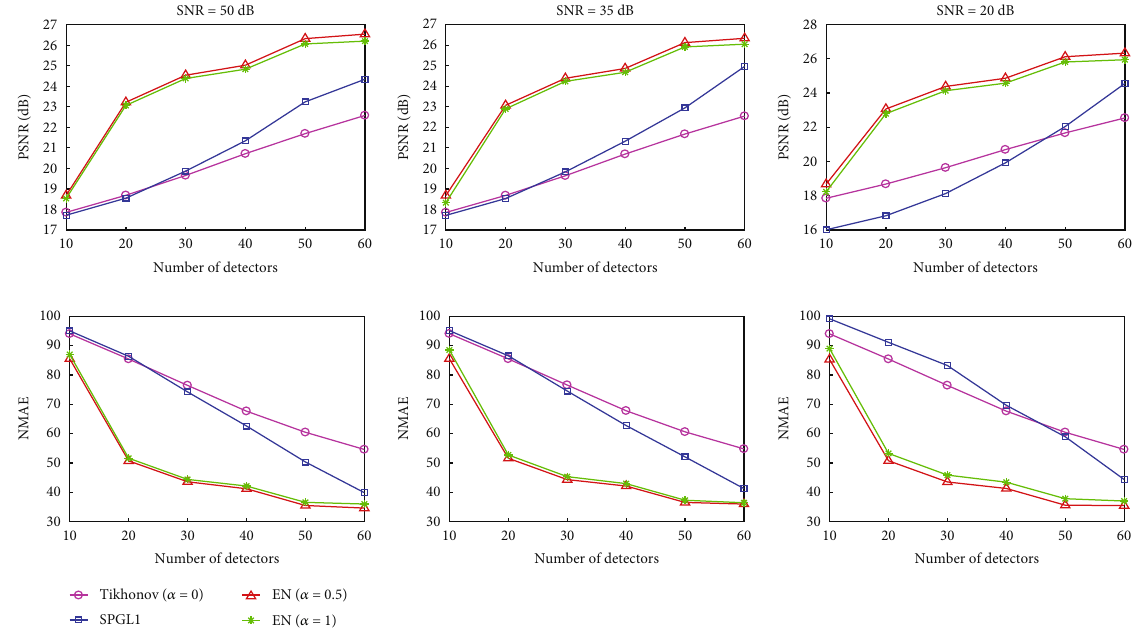
Figure 5: The trend of PSNR and NMAE values with increasing sampling number. The fi rst and second rows show the trend graph of the PSNR and NMAE values of reconstructed images using signals with noise levels of SNR = 50 , 35, and 20dB,